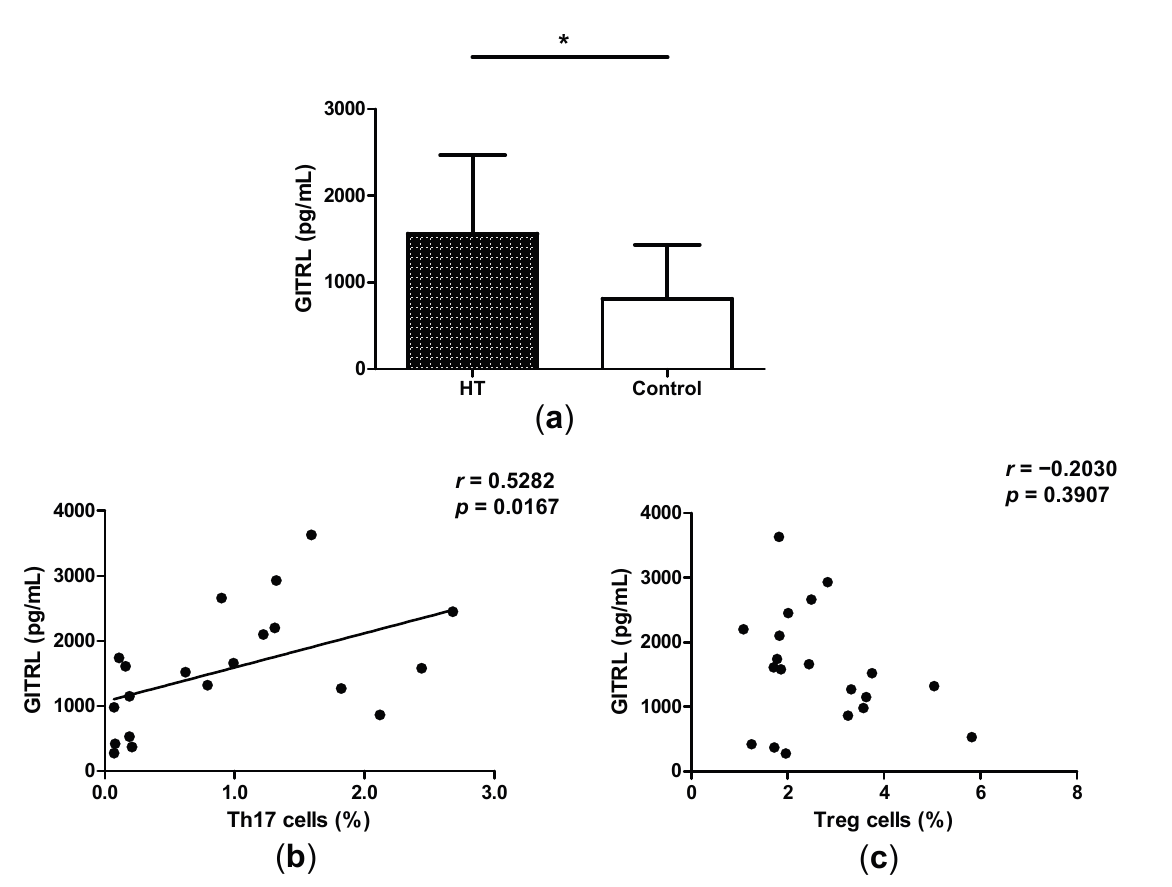
Figure 4. High levels of GITRL in patients with HT. ( a ) Serum levels of GITRL were determined by ELISA in serum samples from HT patients and controls; ( b ) The correlation between the percentage of Th17 cells and serum levels of GITRL in HT patients and ( c ) The correlation between the percentage of Treg cells and serum levels of GITRL in HT patients. * p <